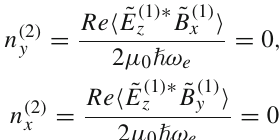
Table 1 The EM response to the KK-HFGWs from the braneworld [21] in the galactic–extragalactic magnetic fields, where N ( 2 ) is the perturbative photon flux densities (m − 2 s − 1 ), P is corresponding EM